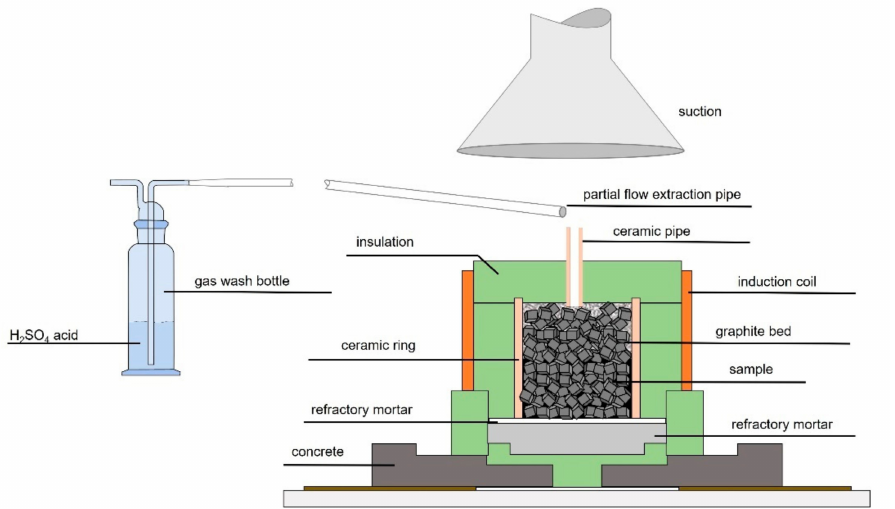
Figure 1. Schematic illustration of the InduMelt reactor used in the experimental trials with NMC532, NMC622, and